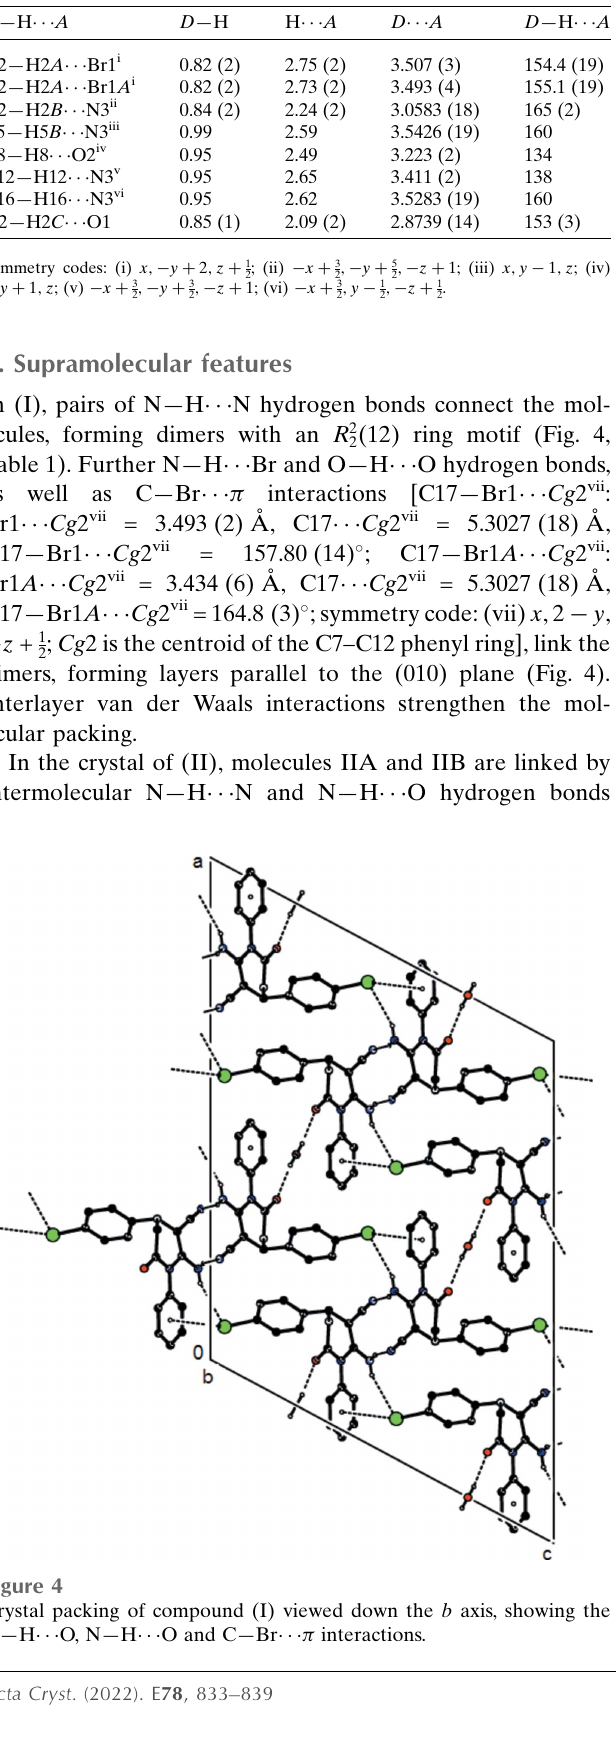
Table 1 Hydrogen-bond geometry (A˚ , (cid:3) ) for